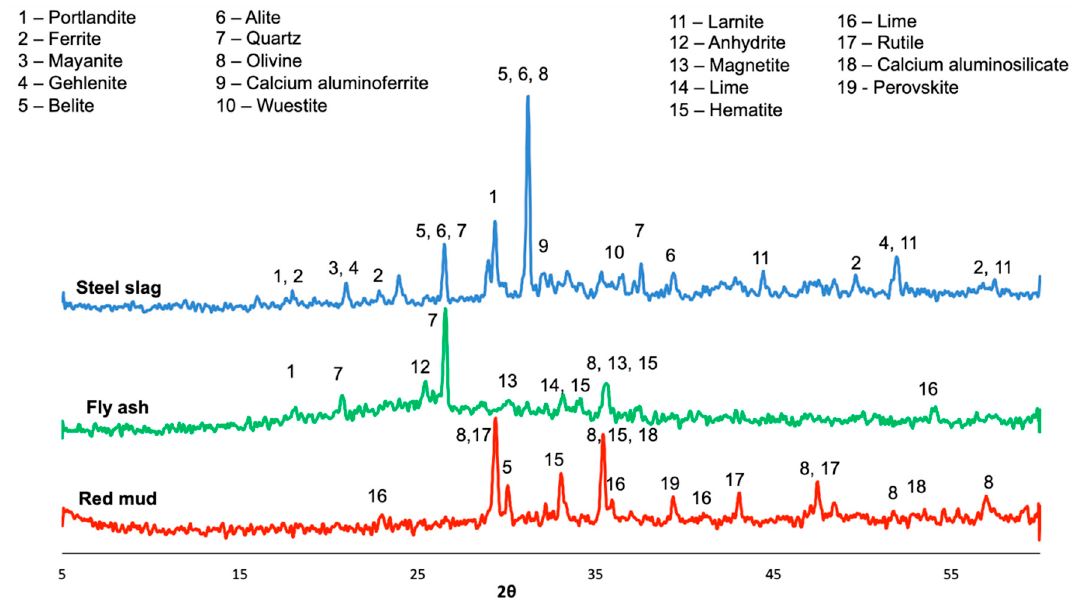
Figure 3. x-ray diffraction (XRD) results for red mud, fly ash and steel slag. Figure 3. x-ray di ff raction (XRD) results for red mud, fly ash and steel